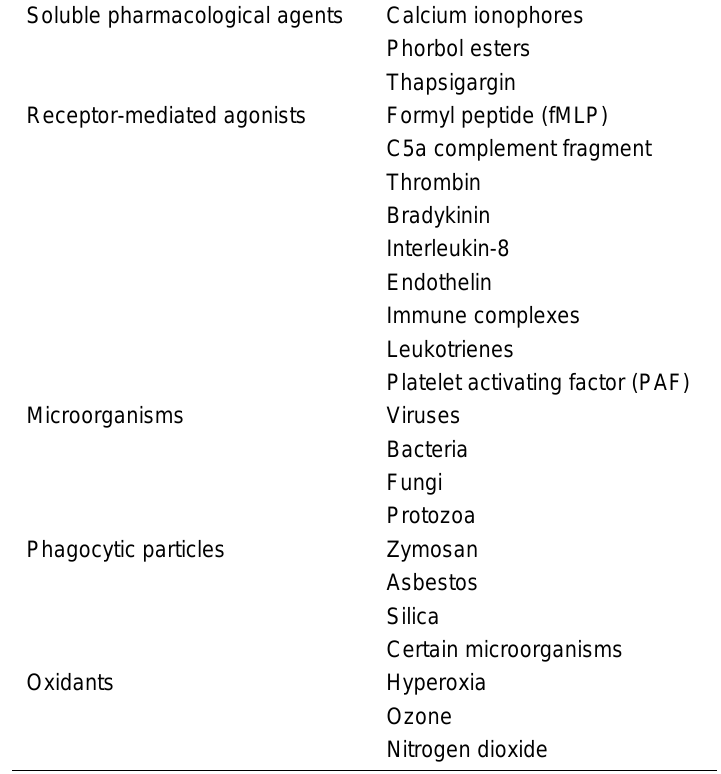
Representative “Complete” Activators of Eicosanoid Biosynthesis Soluble pharmacological